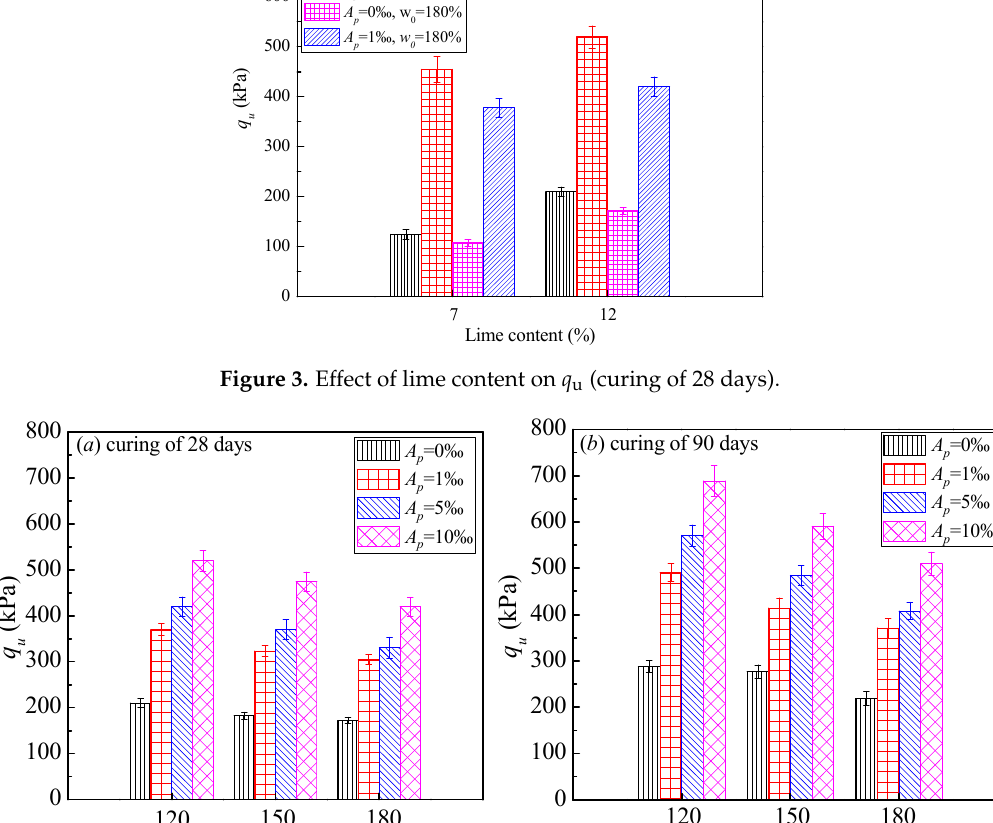
Figure 4. Effect of initial water content on q u ( A L = 12%).